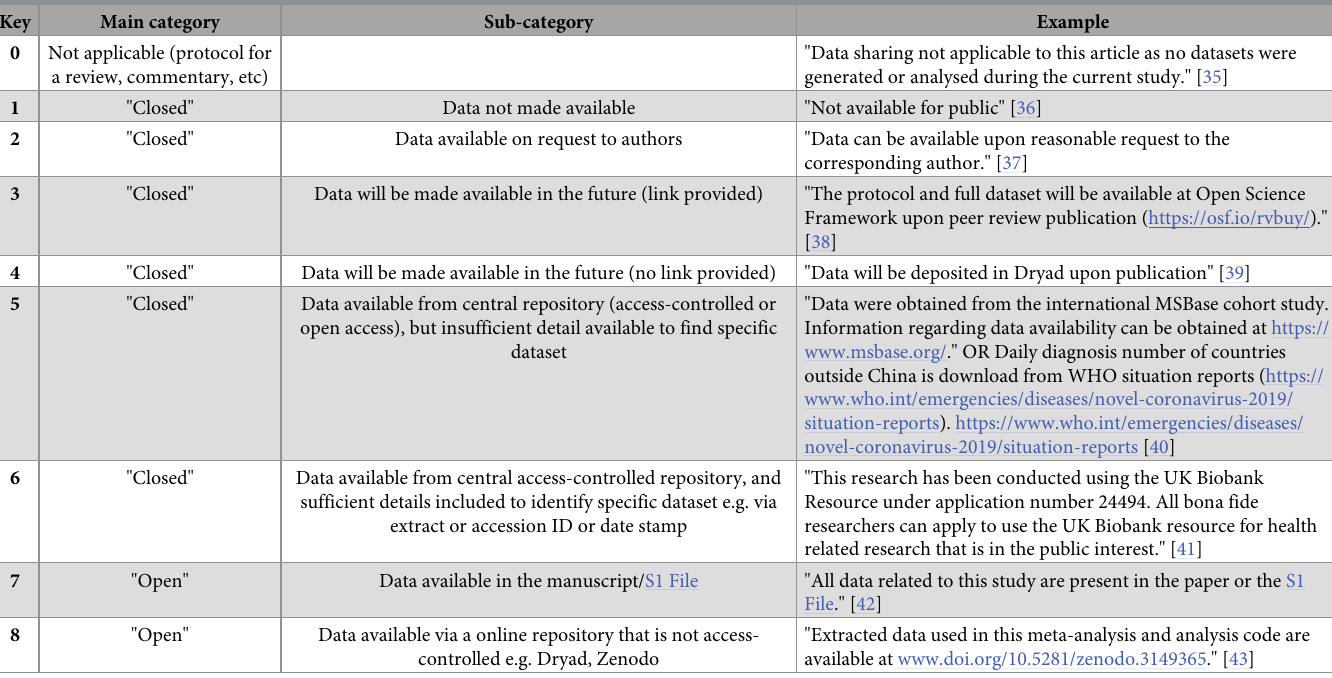
Table 1. Categories used to classify the data availability